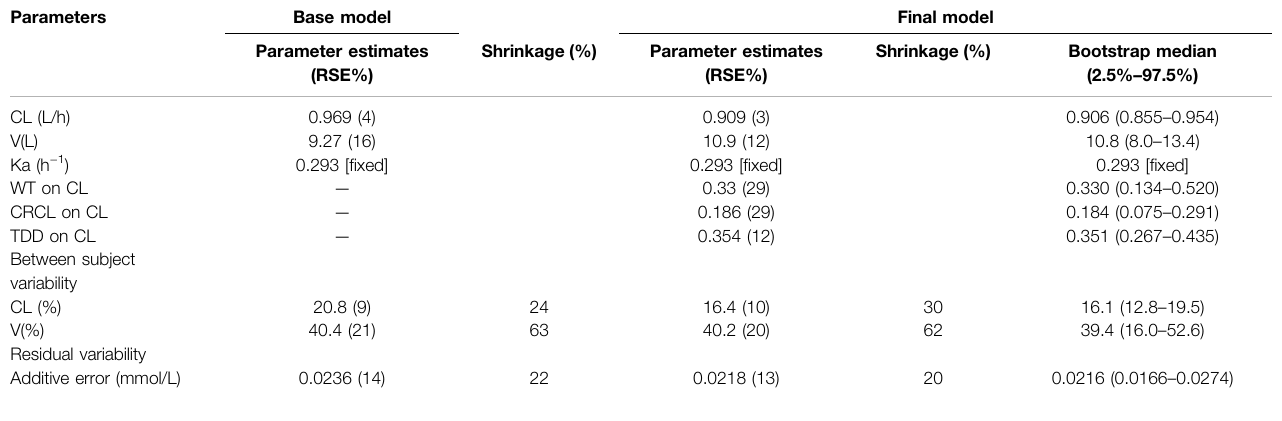
TABLE 2 | Population-pharmacokinetic parameter estimates and bootstrap evaluation.